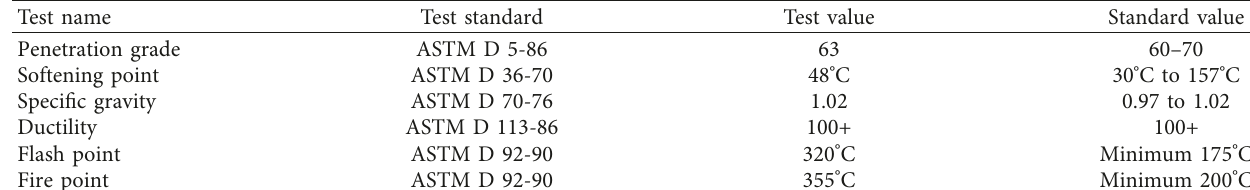
Table 3: Test results of physical properties of asphalt binder.